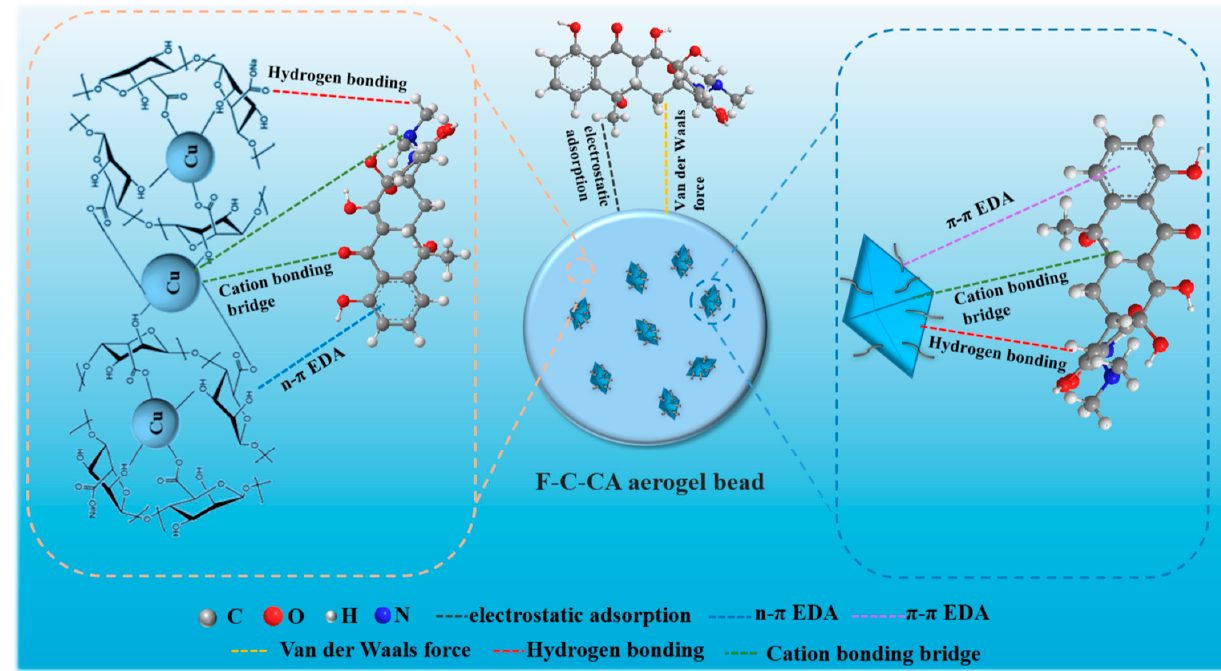
Figure 8. The adsorption mechanism of F-C-CA aerogel beads on TC.